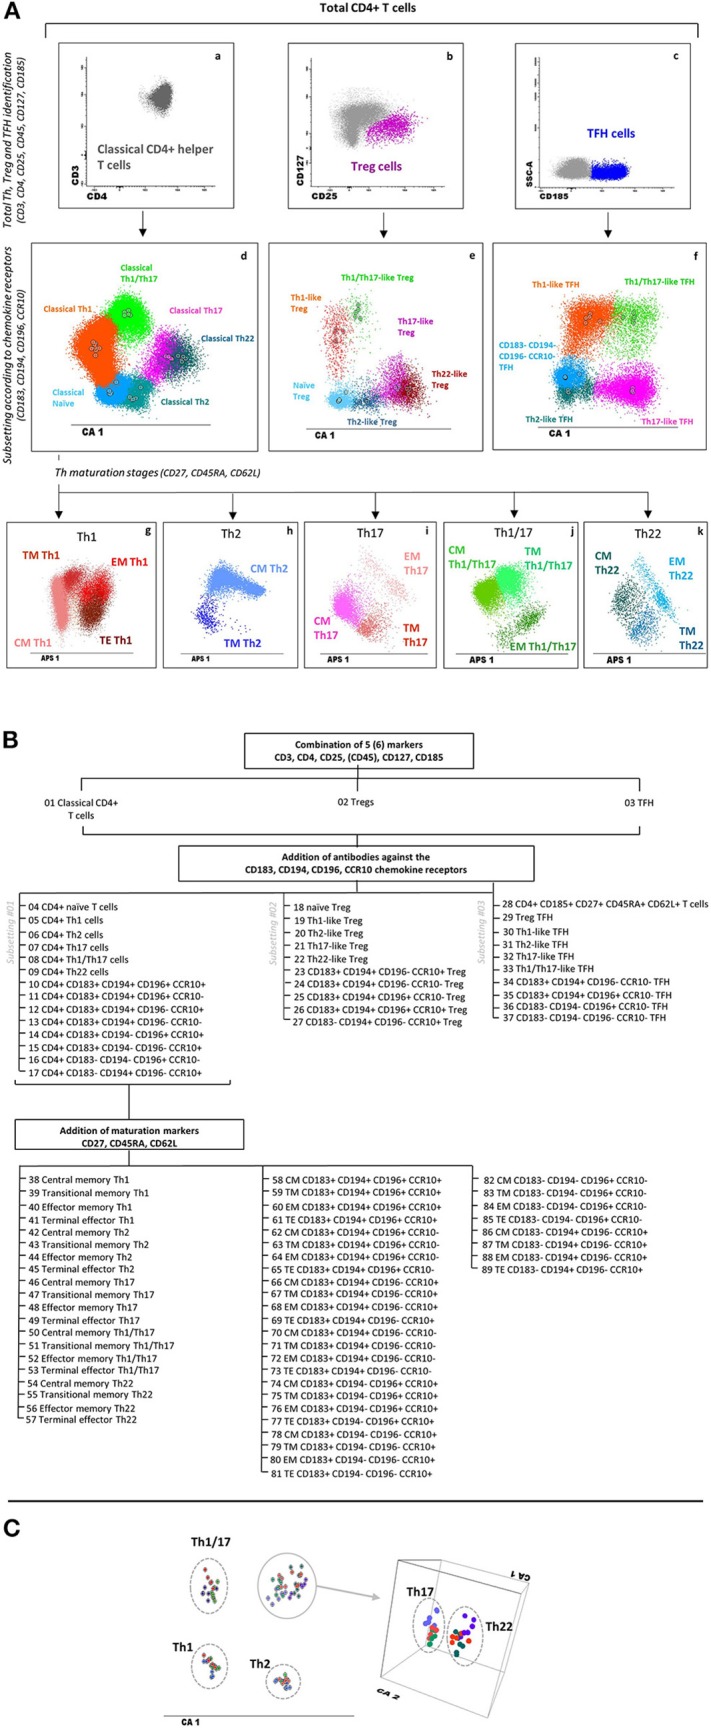
Major T helper, Treg, and TFH populations identified with the EuroFlow immune monitoring (IMM) TCD4 tube and reproducibility of phenotypic data obtained at different centers. (A) Sequential strategy used for the identification of total classical helper CD4+ T cells (a), Tregs (b), and TFH cells (c) using CD3, CD4, CD25, CD45, CD127, and CD185. Within each major population, different Th and Th-like subsets are identified based on the expression of CD183, CD194, CD196, and CCR10, as shown in panels d, e, and f for classical Th cells, Tregs, and TFH cells, respectively, via canonical multivariate analysis (CA). Finally, within each Th subset, distinct maturation stages are identified based on their expression profile for CD27, CD45RA, and CD62L, as displayed in two-dimensional automatic population separator (APS) views—principal component (PC)1 vs. PC2—in panels g–k for classical Th cells. (B) Dendrogram showing a detailed subsetting of a total of 89 different CD4+ T-cell populations identified with the EuroFlow IMM TCD4 tube. (C) CA showing 18 healthy adult blood samples stained at three different centers [Universidad de Salamanca (USAL), n = 6; Leiden University Medical Center (LUMC), n = 7; Rijksinstituut voor Volksgezondheid en Milieu (RIVM), n = 5] to evaluate data reproducibility. Th subsets from USAL, LUMC, and RIVM samples are presented in shades of blue, green, and red, respectively. Solid circles represent median values for the six parameters evaluated (CD3, CD45, CD183, CD194, CD196, and CCR10) in the CA1 diagram. Th17 and Th22 cells are presented in a three-dimensional CA diagram to clearly show separation between these two subsets. Markers contributing to CA1 (percentage contribution) were CD194 (37%), CD183 (32%), CCR10 (17%), CD3 (7%), CD45 (6%), and CD196 (1%). Treg, regulatory T cells; TFH, follicular helper T cells; Th, T helper cells; CM, central memory; TM, transitional memory; EM, effector memory; TE, terminal effector CD4+ T cells.